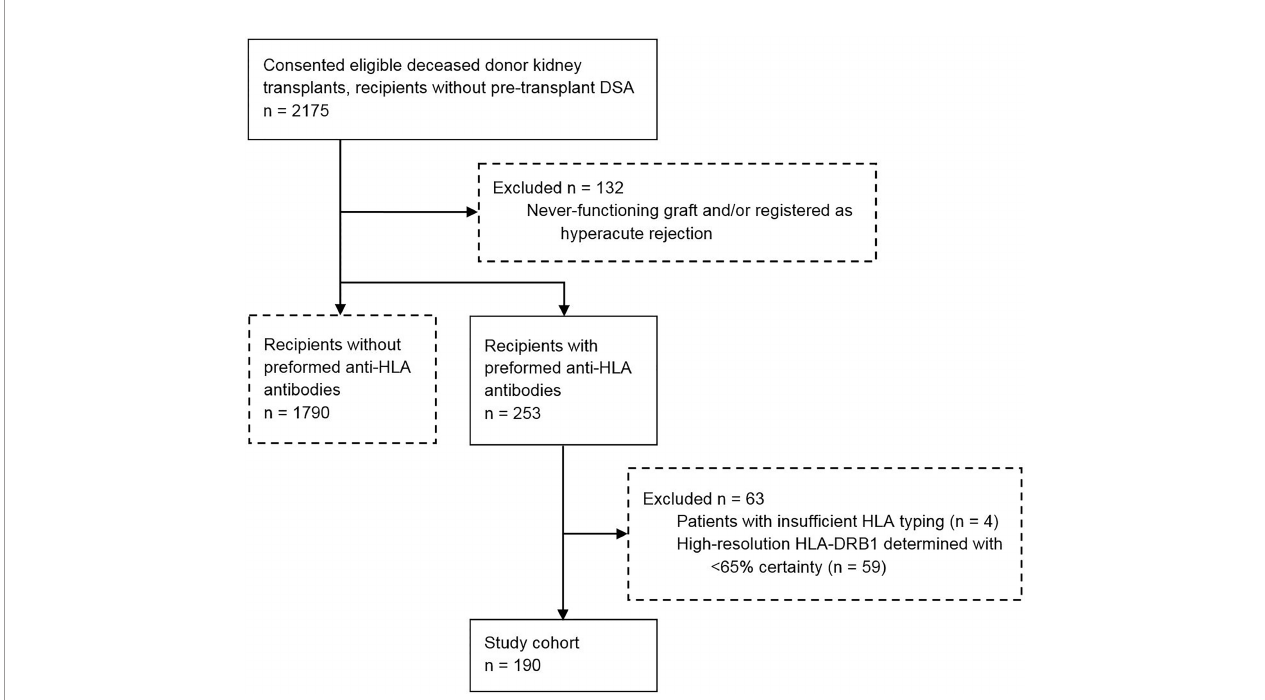
FIGURE 1 | Inclusion and exclusion criteria. Boxes with dotted lines represent excluded